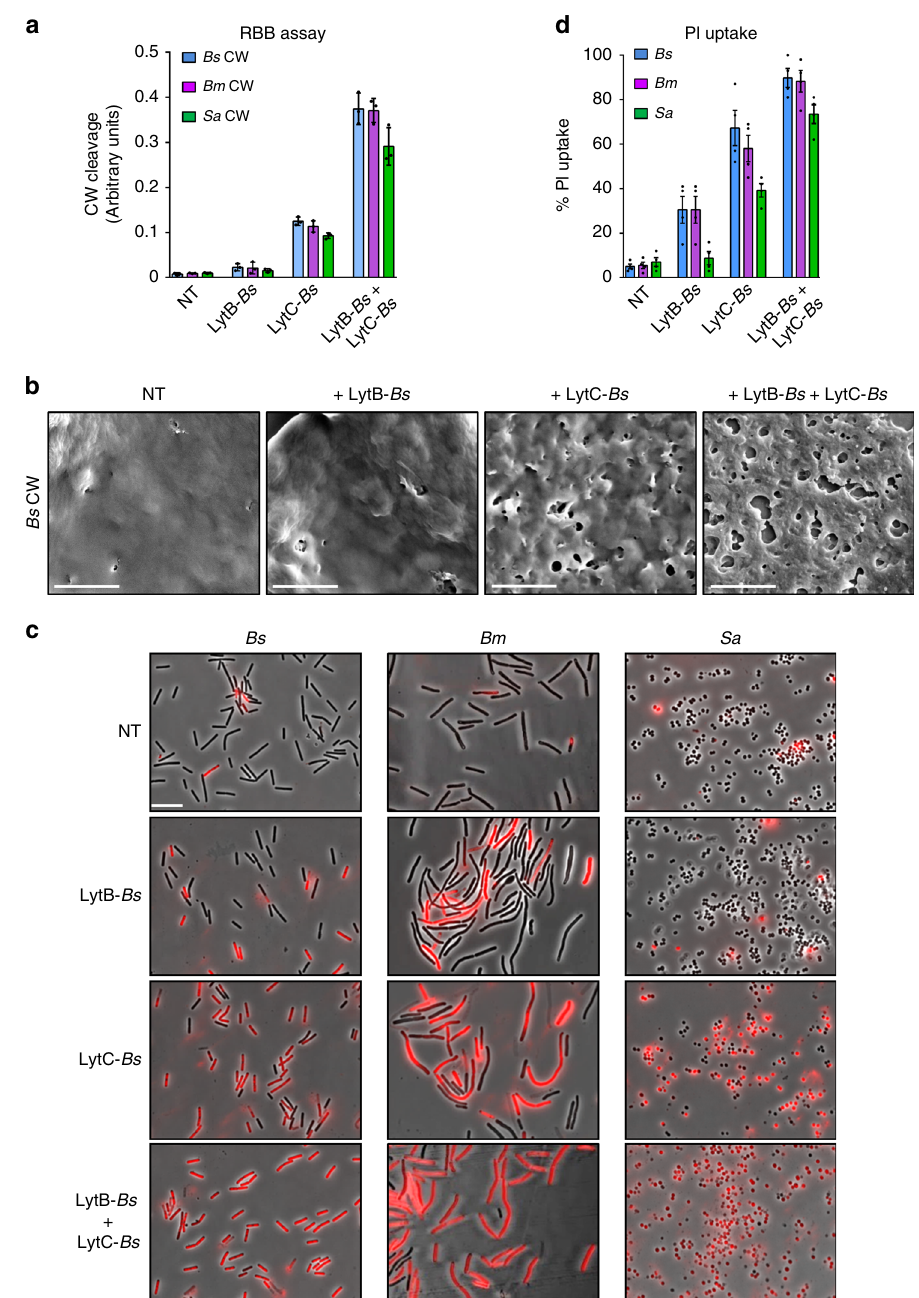
Fig. 5 LytB- Bs and LytC- Bs can exogenously cleave CW of foreign species. a CWs were isolated from Bs (PY79), Bm (OS2), or Sa (MRSA), labeled with RBB, mixed with puri fi ed LytB- Bs , LytC- Bs or both. The cleaved products were separated by centrifugation and absorbance of supernatant was measured at 595 nm. Shown are mean ± SEM of at least three independent experiments. b Bs sacculi derived from PY79 cells were incubated for 30 min with puri fi ed LytB- Bs , LytC- Bs or both, spotted onto poly L -lysine coated coverslips and visualized by XHR-SEM. Scale bars represent 500 nm. c Bs (PY79), Bm (OS2) or Sa (MRSA) cells were incubated for 10 min with puri fi ed LytB- Bs , LytC- Bs or both, stained with PI and visualized by fl uorescence microscopy. Shown are overlay images of phase contrast (gray) and fl uorescence from PI staining (red). Scale bar represents 5 μ m. d Quantitation of PI uptake by Bs (PY79), Bm (OS2), or Sa (MRSA) cells treated as described in c . Shown is the percentage of PI-labeled cells and mean ± SEM of at least three independent experiments ( n cells = 400). NT indicates no treatment (samples contained only buffer). The experiments were repeated at least three times independently with similar results. Source data are provided as a Source Data fi